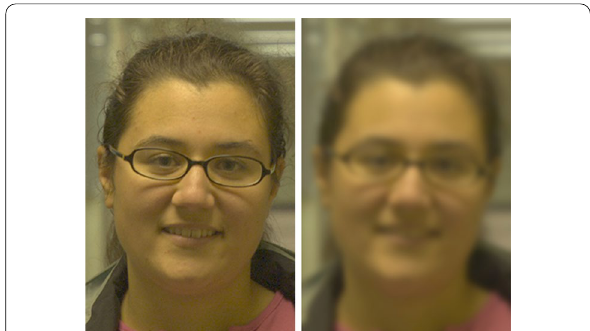
Fig. 1 An example of a “high quality” facial image (left) and “low quality” facial image (right). The image on the right has been given a mosaic pixelation of 16 pixels in diameter using Adobe